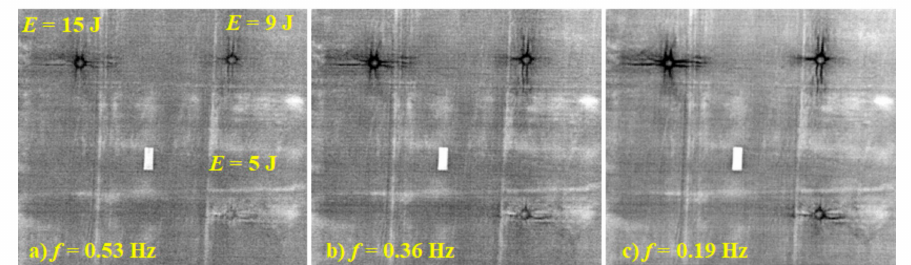
Figure 7. Phase images taken on the impacted side of the pure polypropylene (PPB) specimen at three heating frequencies; ( a ) f = 0.53 Hz; ( b ) f = 0.36 Hz; ( c ) f = 0.19 Hz.